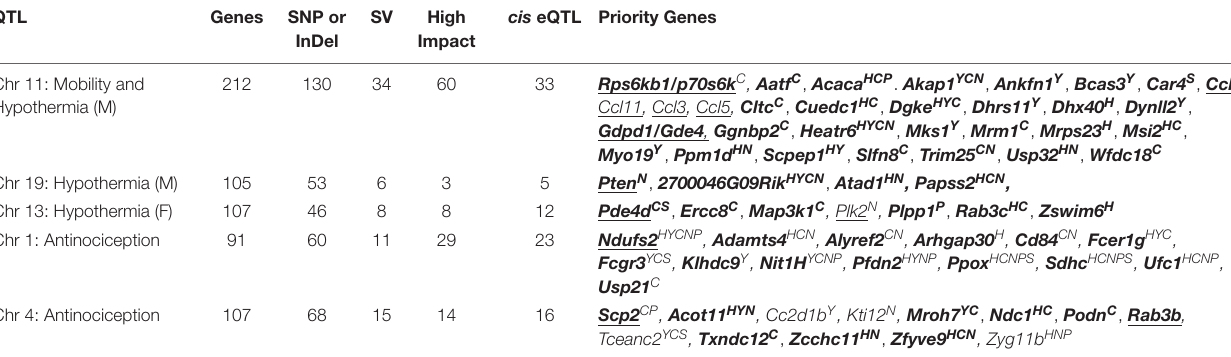
TABLE 3 | Summary of genes with variants and high impact variants within QTL